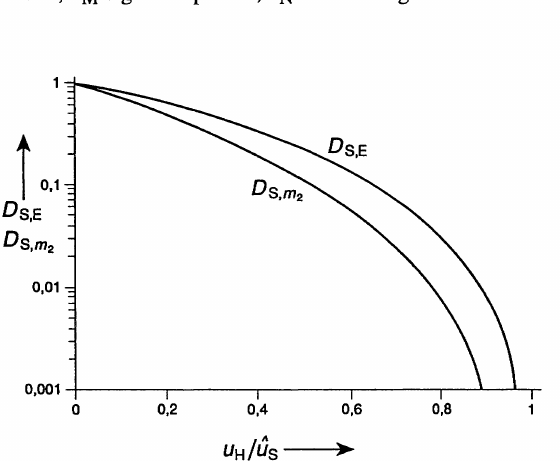
FIGURE 8 Damping rates of the relative error electric noise as a function of the normalized trigger hystere sis (Eqs. (20), (21)). DN,E damping rate for expected value N), E(e DN V damping rate for variance s2. , UH trigger hys- , eN teresis, UM signal amplitude, UN noise voltage rms value.